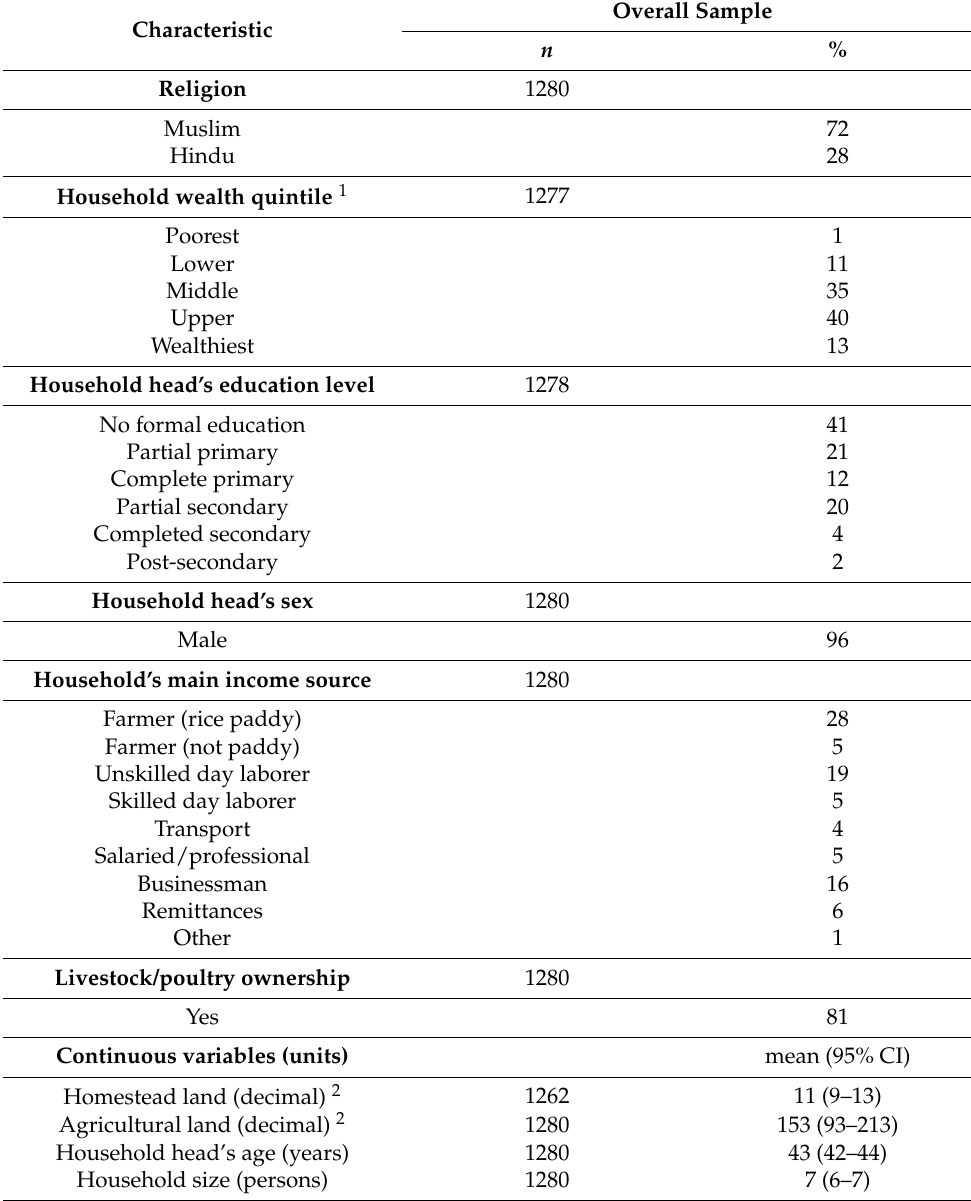
Table 1. Demographic and socio-economic characteristics of the study